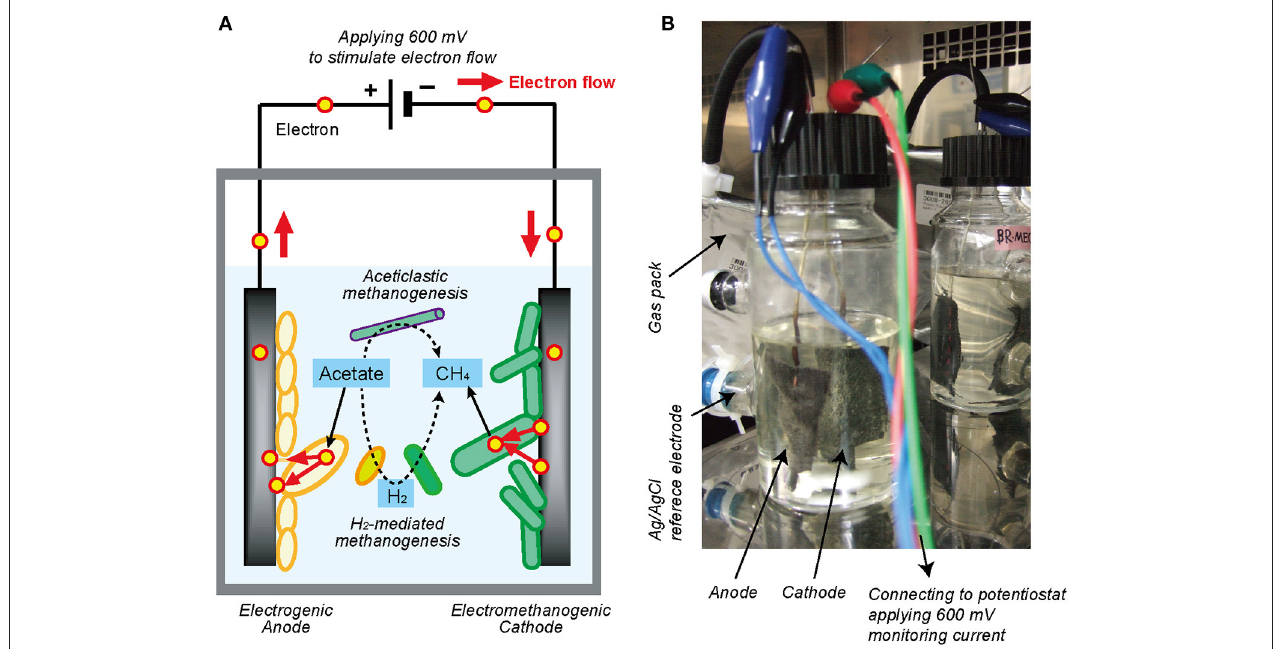
FIGURE 1 | Single-chambered bioelectrochemical system (BES) reactor used in this study. (A) Schematic diagram of electromethanogenesis that is stimulated by accelerating external electron flow with voltage input in a BES reactor. The EET flow for the electromethanogenesis is shown by solid arrow, while competitive methanogenic reactions are shown by dashed lines. (B) The single-chambered BES reactors filled with formation water at natural gas field. Anode and cathode were connected to potentiostat and apply 600mV between them. An Ag/AgCl reference electrode was used for monitoring electrode